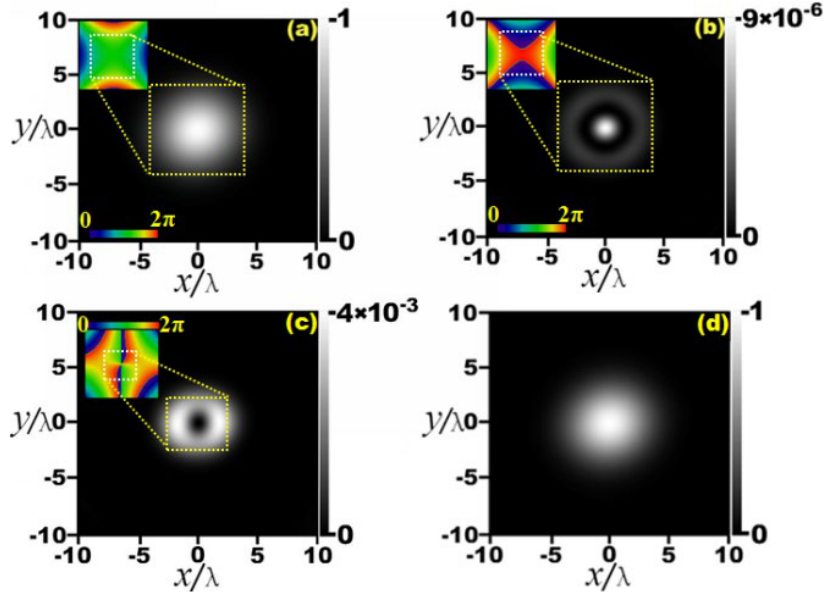
Figure 2. Intensity distributions in focal plane, ( a ) x ₋ polarization component, ( b ) z ₋ polarization component, ( c ) y ₋ polarization component, ( d ) total intensity. Parameters for calculation are chosen as λ = 633 nm, α = 3, NA = 0.9, f = 3.4 cm, μ = 10 mm −2 , and E 0 = 1.